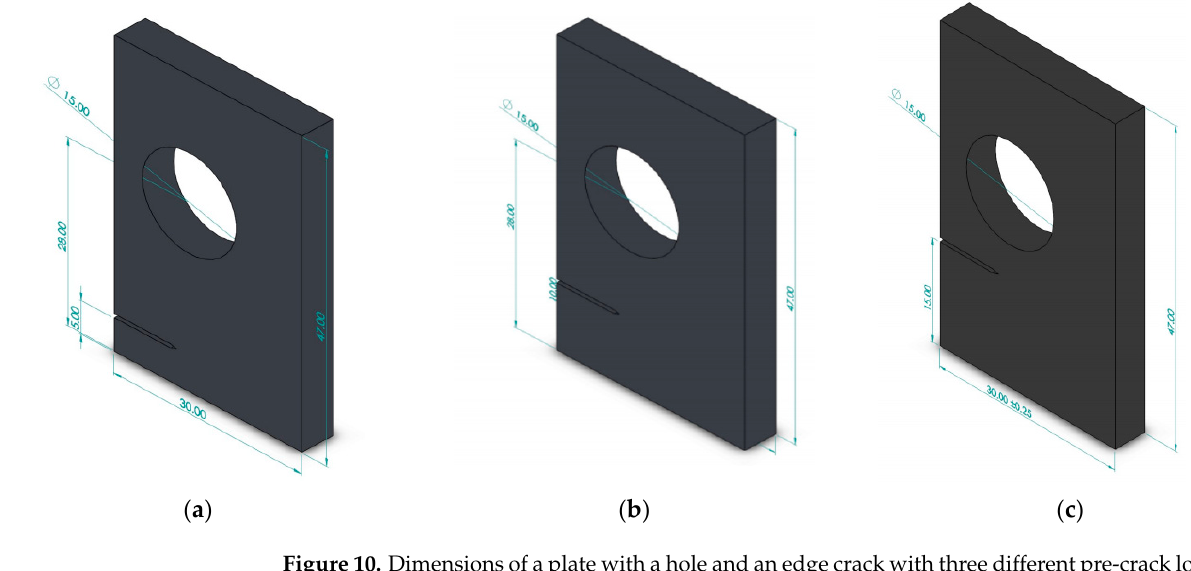
Figure 10. Dimensions of a plate with a hole and an edge crack with three different pre-crack locations, ( a ) h = 5 mm, ( b ) h =10 mm, and ( c ) h = 15 mm.